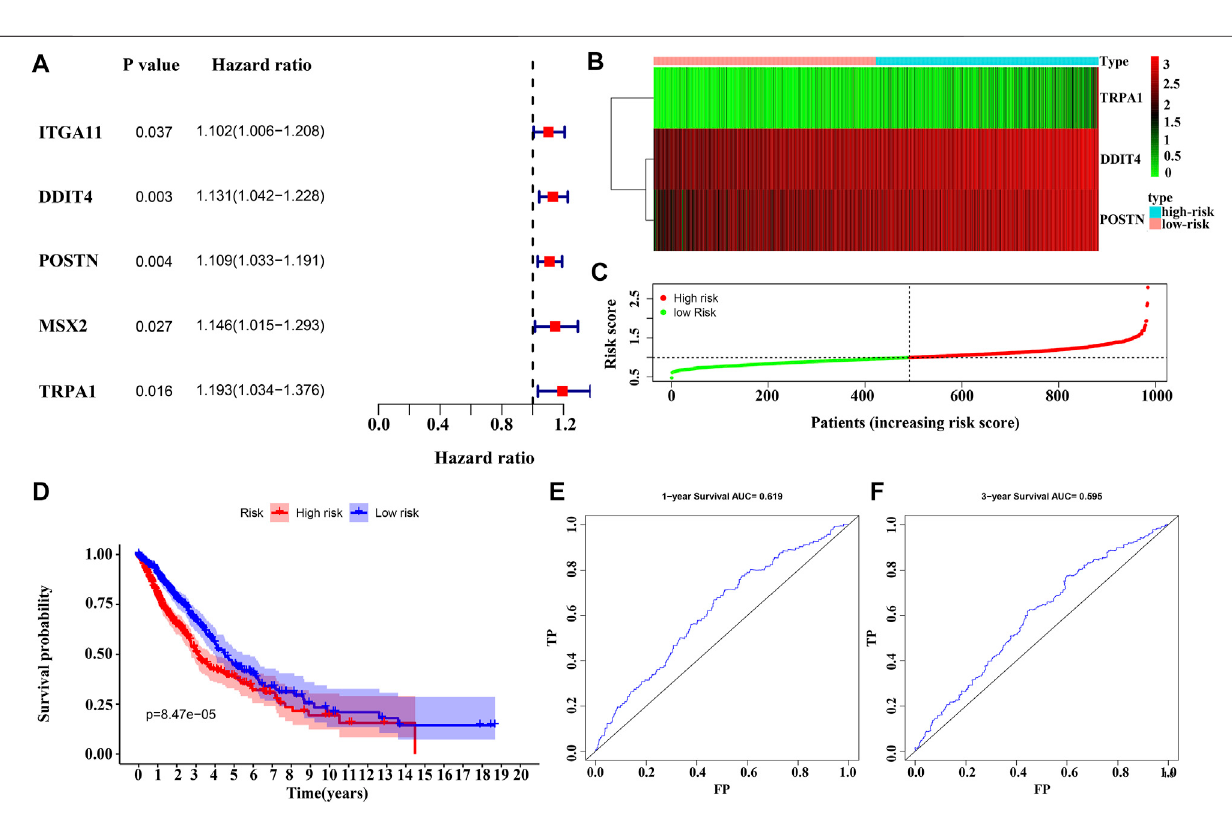
Frontiers in Genetics |